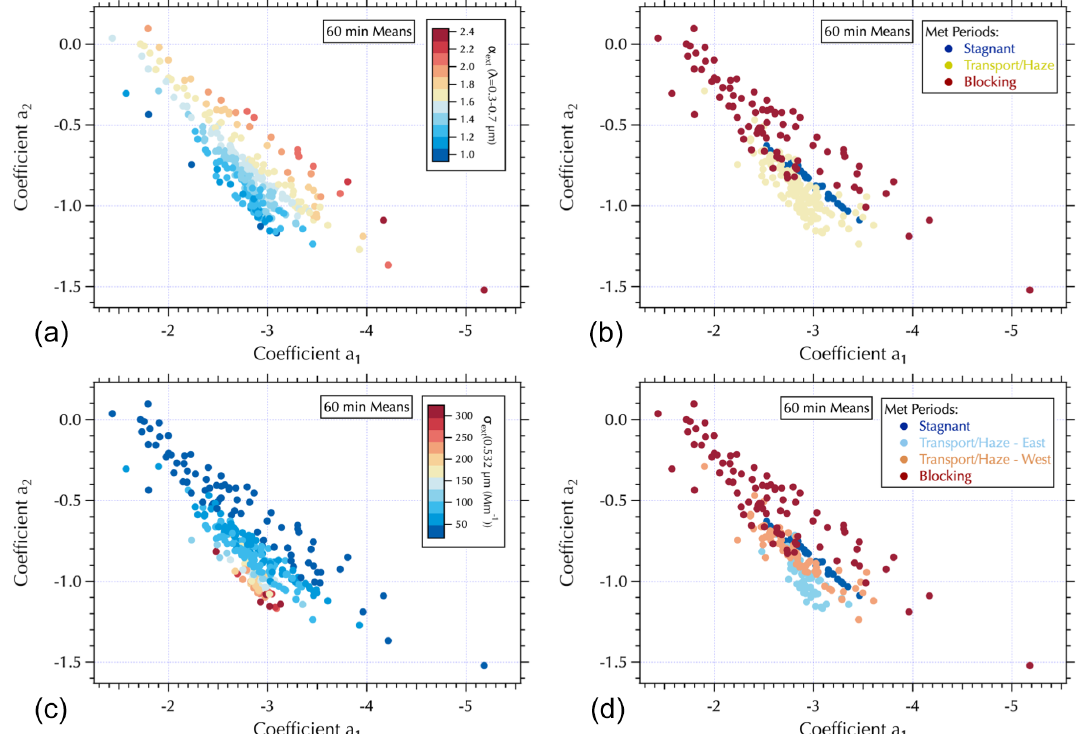
Figure 10. Coefficients a 2 vs. a 1 from second-order polynomial fits to the full wavelength range (0.3–0.7µm) of the 60min mean spec- tra colored by α ext ( λ = 0.3–0.7µm) (a) , σ ext (0.532µm )( Mm − 1 ) (c) , and the defined meteorological periods described in Peterson et al. (2019) (b) (i.e., excluding the interval when the meteorological regime was in transition, 23 and 24 May, and hence undefined). Panel (d) is the same as panel (b) but with the Transport/Haze samples split between those measured to the east (25–27 May) and west (29–31 May) of the peninsula, excluding those samples collected in transit between the